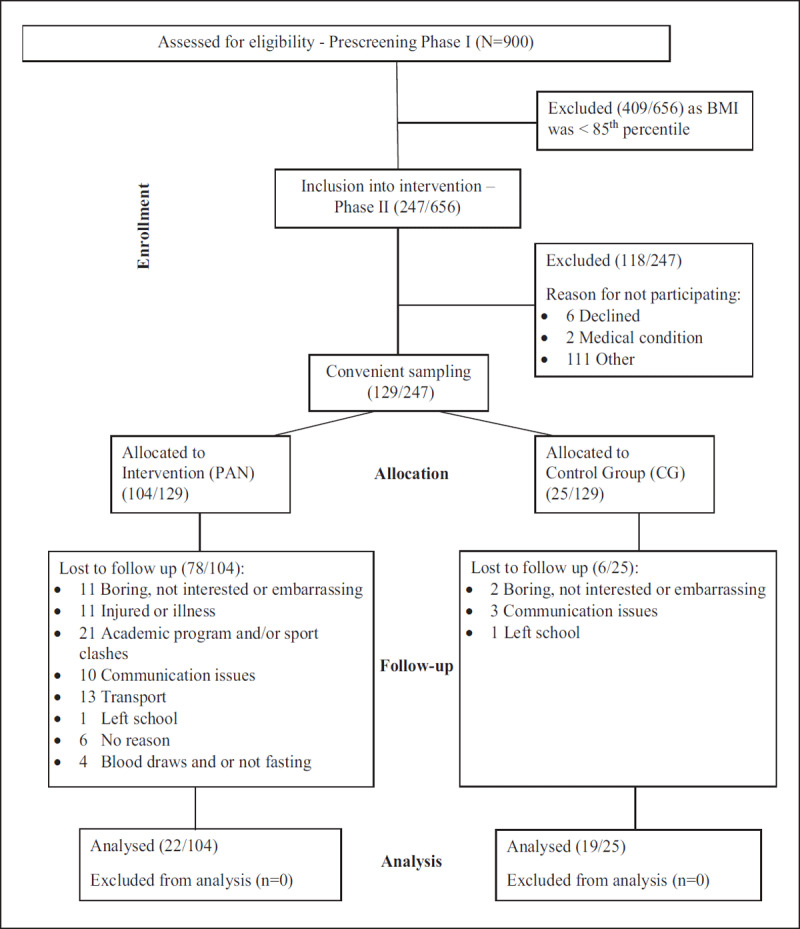
Consort diagram showing the participant’s flow through the study.